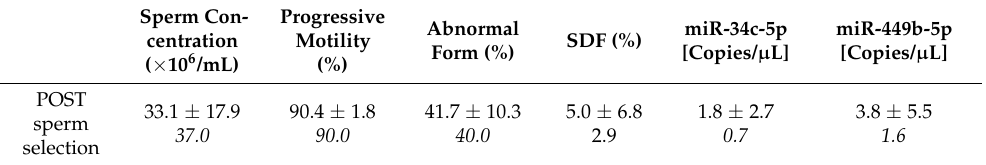
Table 9. Summary characteristics of molecular study subpopulation post selection. Continuous variables are presented as mean ± SD and median (in